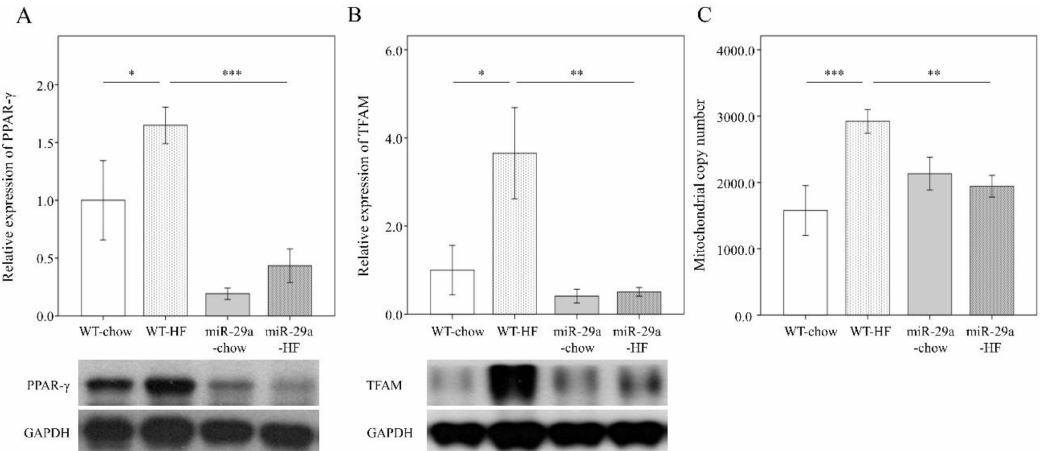
Figure 6. Overexpression of miR-29a modulates HFD-caused perturbation of mitochondrial biogenesis in the liver. Representative immunoblotting bands and densitometric results of ( A ) peroxisome proliferator-activated receptor γ (PPAR γ ) and ( B ) mitochondrial transcription factor A (TFAM), using GAPDH as the loading control. ( C ) mtDNA copy number per cell probed using qPCR, with TERT as the normalization control. Five to ten specimens were used for each group. Data are expressed as mean ± SE. * p < 0.05, ** p < 0.01, and *** p < 0.001 between the indicated groups. WT, wild